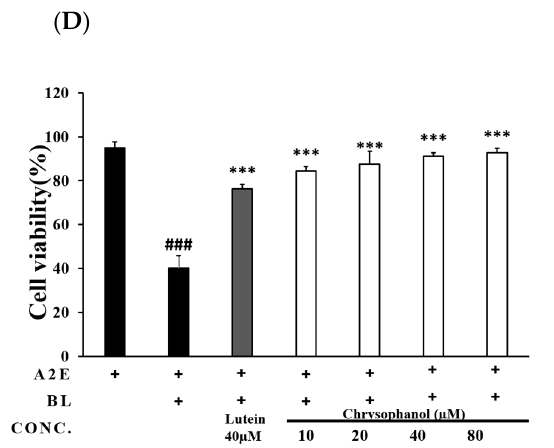
Figure 4. Results of cell cytotoxicity in each group using LDH assay. Cassia tora seed extract, frac- tionation, and compounds inhibit blue-light-induced damage in ARPE-19 cells. ( A ) Cell cytotoxicity of extract, ( B ) n -hexane fraction, ( C ) rubrofusarin, and ( D ) chrysophanol. Cell death was quantified by LDH assay; absorbance value was normalized to untreated control samples (only A2E-loaded ARPE-19 cells). Values are mean ± SEM of three independent experiments performed at different times. * p < 0.05, and *** p < 0.001 vs. A2E blue light group; ### p < 0.001, positive control vs. A2E blue light group. LDH, lactate dehydrogenase; SEM, standard error of mean.